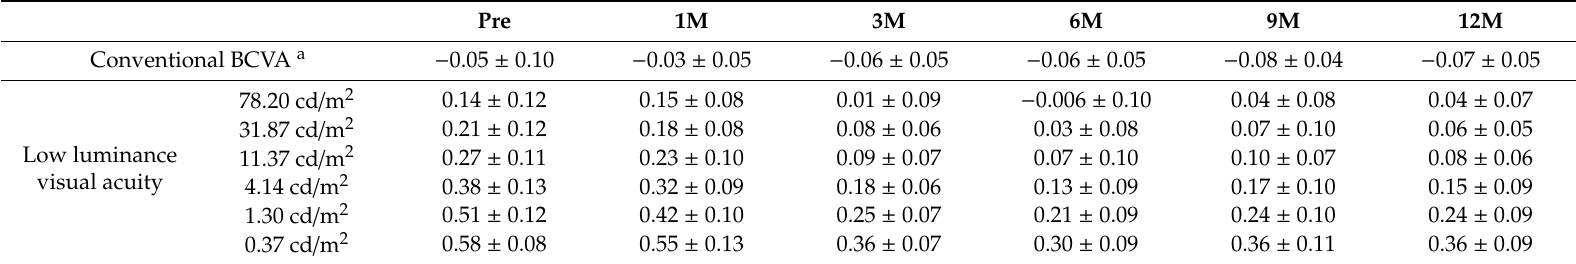
Table 2. Conventional best corrected visual acuity and low luminance visual acuity at each follow-up visit. Pre 1M 3M 6M 9M 12M Conventional BCVA a − 0.05 ± 0.10 − 0.03 ±